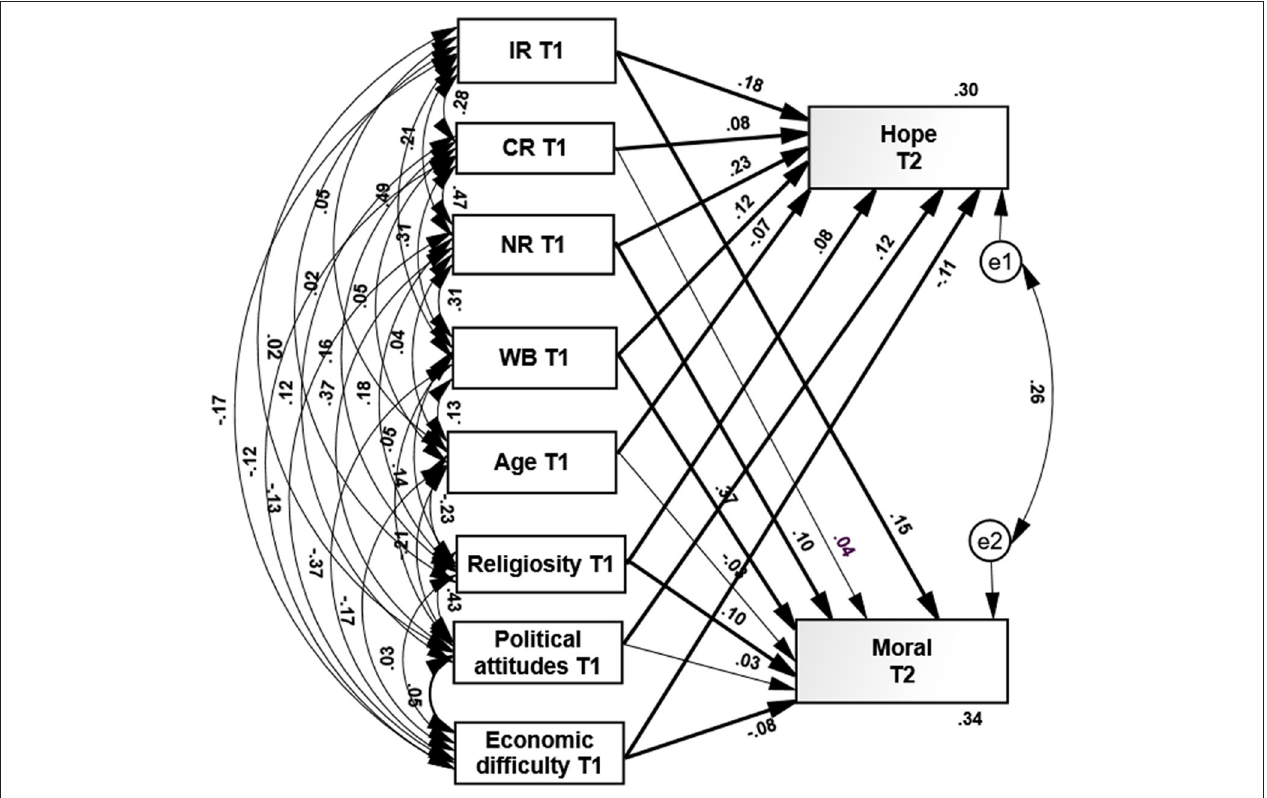
FIGURE 1 | Path analysis of psychological and demographic variables at T1 predicting hope and morale at T2. IR, individual resilience; CR, Community resilience; NR, National resilience; WB, Wellbeing. The thick lines indicates significant paths, the thin lines indicate non-significant